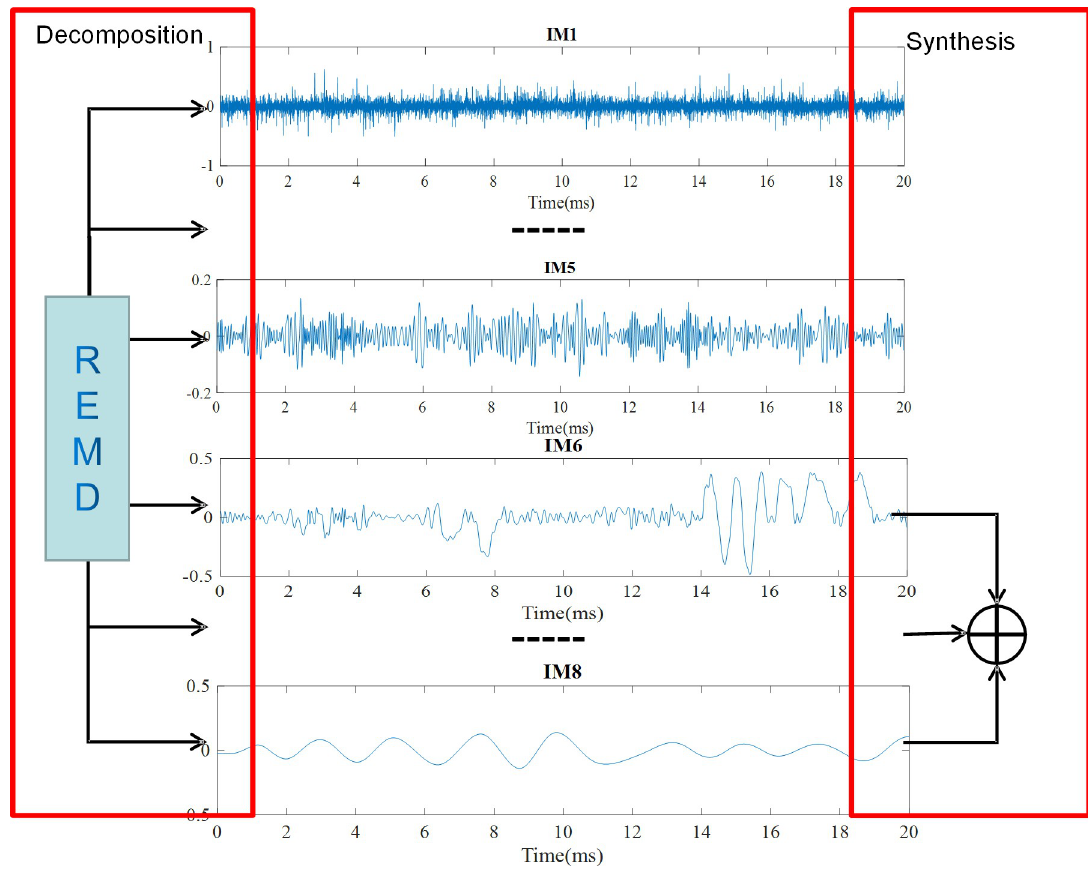
Fig 9. Decomposition and reconstruction process.